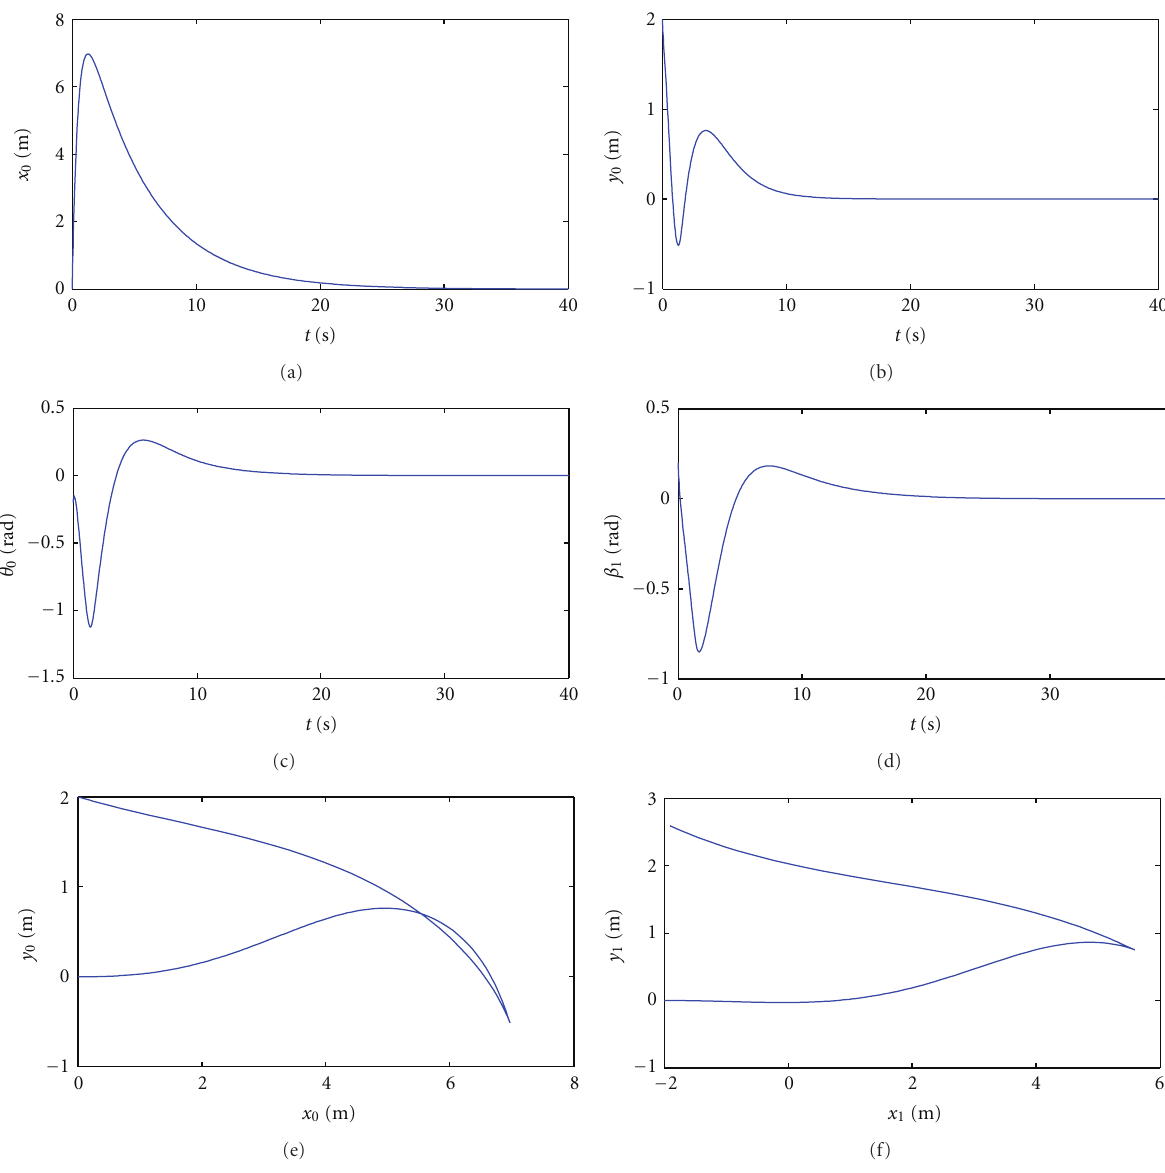
Figure 3: Time trajectories of states and geometric paths of the tractor and the trailer starting from the second initial state.